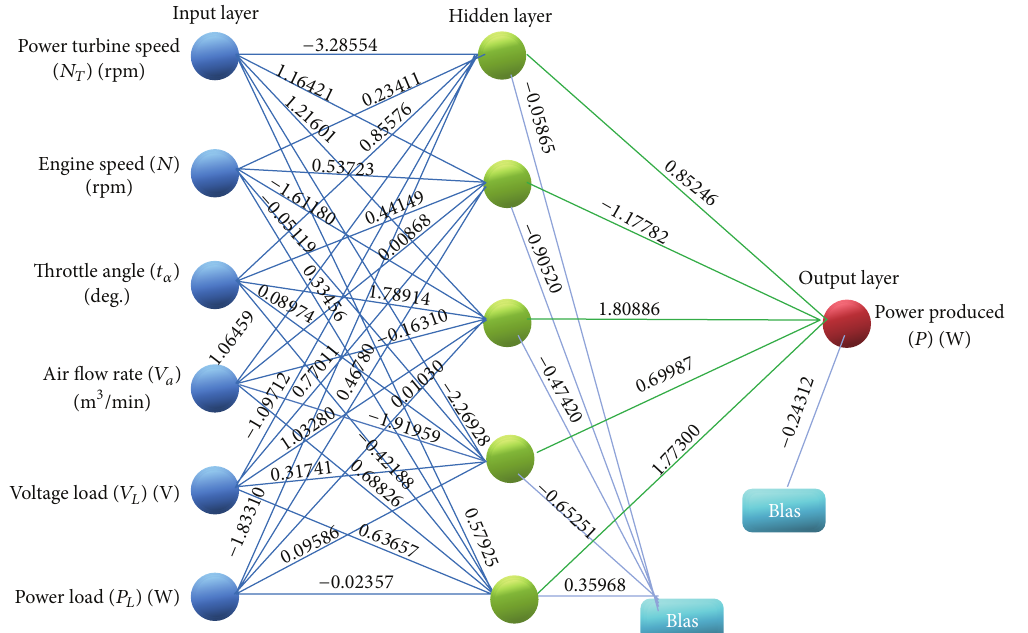
Figure 13: The architecture of MLP 6-5-1 of ANN for prediction of power produced from power turbine speed, engine speed, throttle angle, air flow rate, voltage load, and power load.